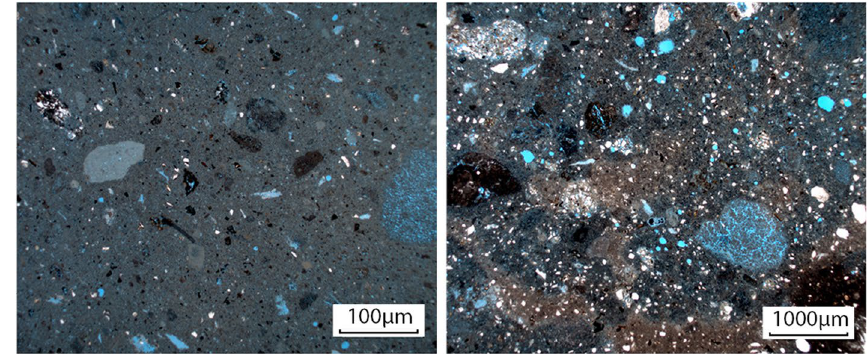
Fig. 21 Mortar matrix of the bedding (left) and pointing (right) mortars from XGW (xpl) (Source: Tanja